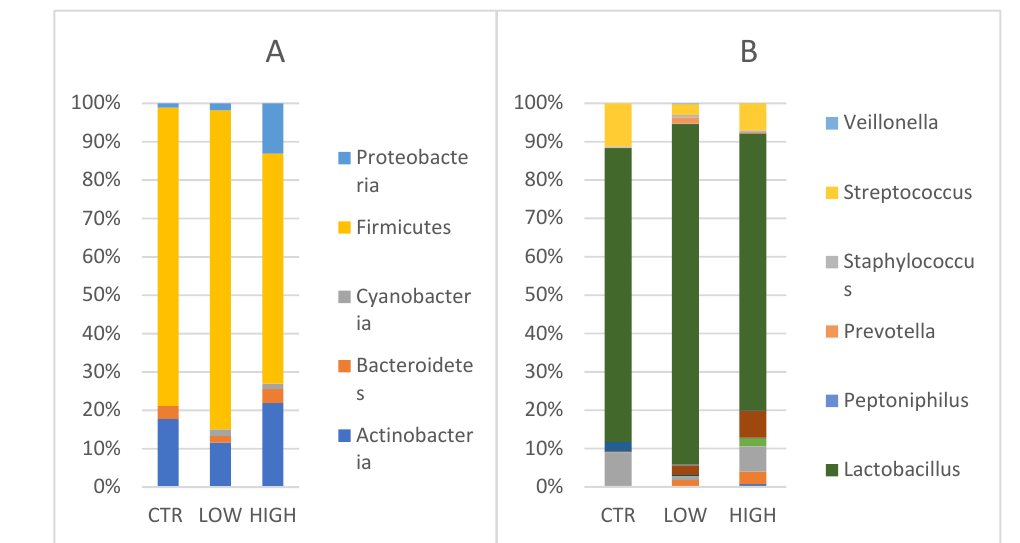
Figure 4. A. Phylum level: Relative abundance detected in vaginal samples CTR = control; Low= Figure 4. ( A ) Phylum level: Relative abundance detected in vaginal samples CTR = control; HLA DQ2 DQ8 negative-RPL; High: HLA DQ2 DQ8 positive-RPL. B. Genus level: Relative abun- Low = HLA DQ2 DQ8 negative-RPL; High: HLA DQ2 DQ8 positive-RPL. ( B ) Genus level: Rel- dances detected in vaginal samples. Legenda: CTR = control; Low= HLA DQ2 DQ8 negative-RPL; ative abundances detected in vaginal samples. Legenda: CTR = control; Low = HLA DQ2 DQ8 High: HLA DQ2 DQ8 positive-RPL. negative-RPL; High: HLA DQ2 DQ8